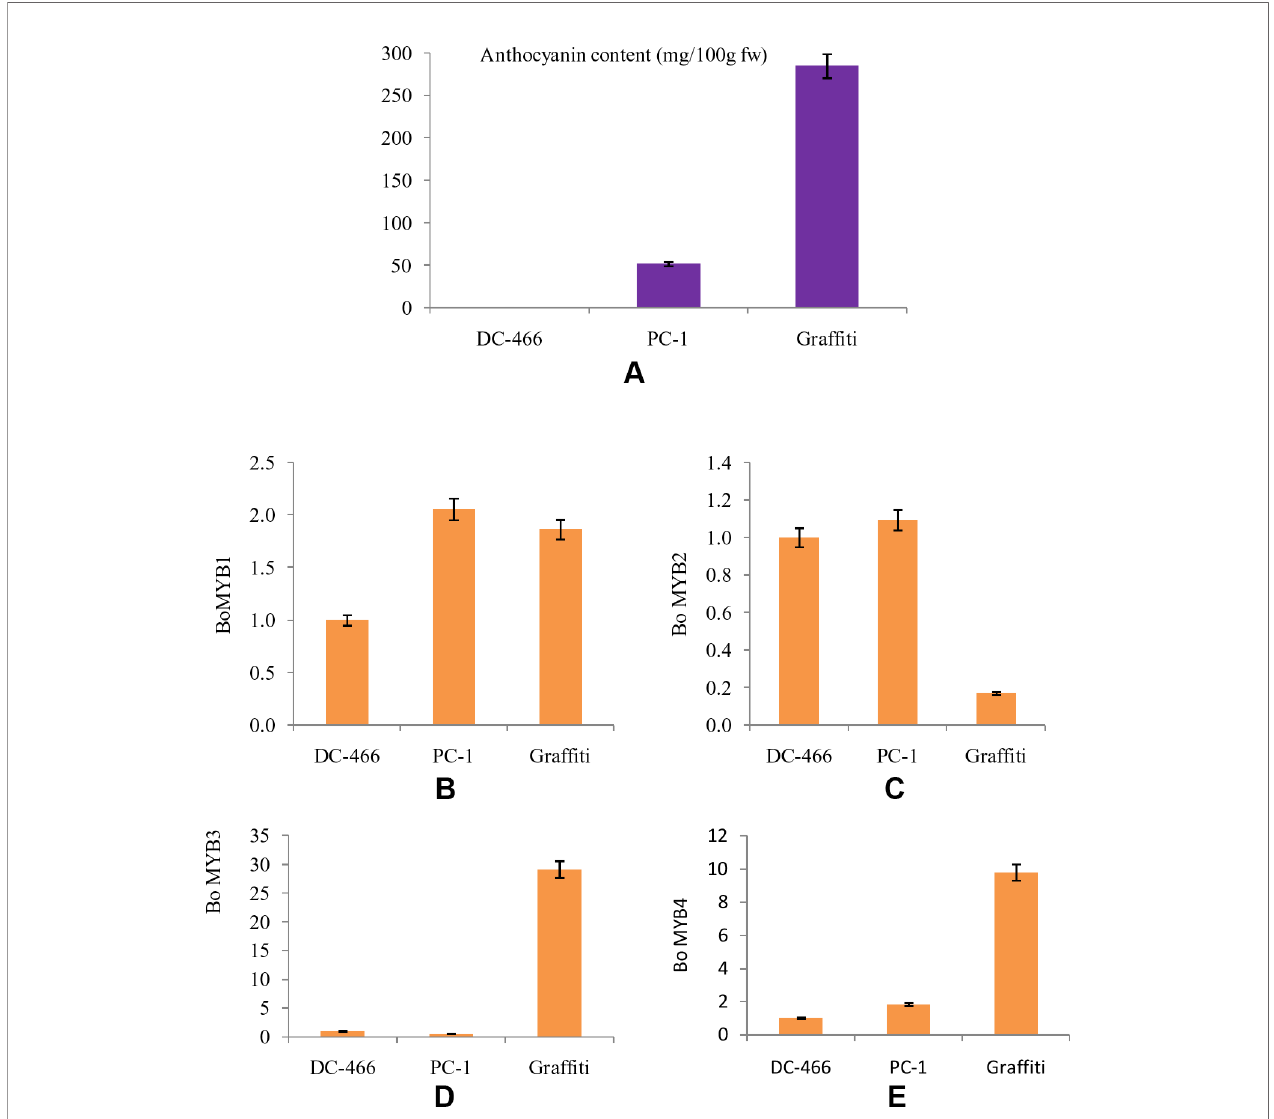
FIGURE 9 | Anthocyanin content in test genotypes (A) , relative fold change in expression of genes, i.e. Bo MYB1 (B) , BoMYB2 (C) , BoMYB3 (D) , and BoMYB4 (E) in DC-466 ’ , ‘ PC-1 ’ , and ‘ Graf fi ti ’